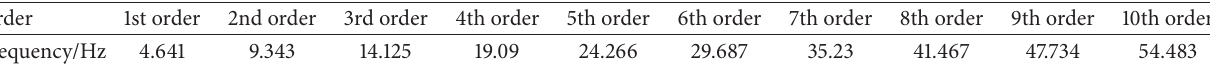
Table 4: Tested frequencies of the cable.